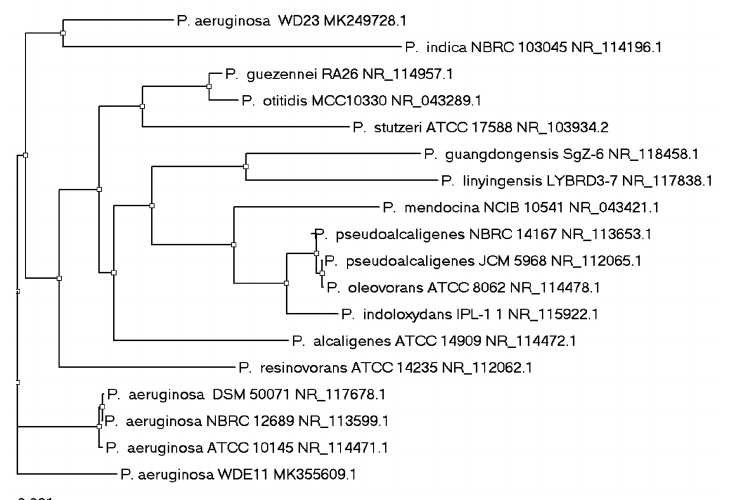
Fig. 4a. Phylogenetic tree showing the relationship of isolated WD22 with isolates showing homology as obtained from